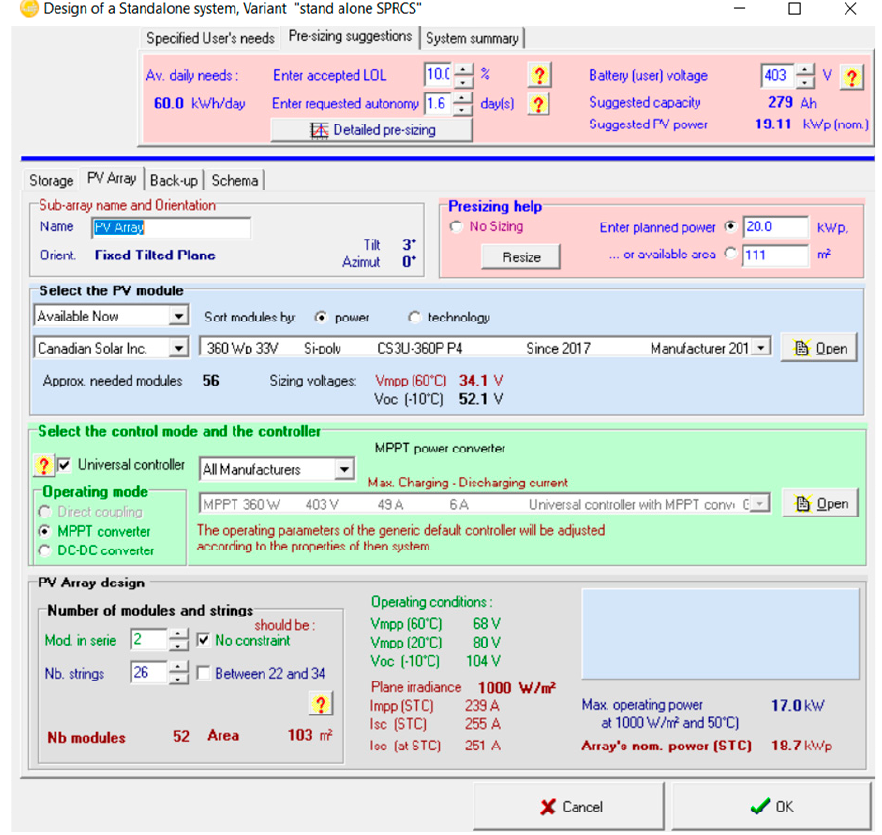
Figure 6. Sizing of standalone PV system for solar photovoltaic rapid charging system (SPRCS).